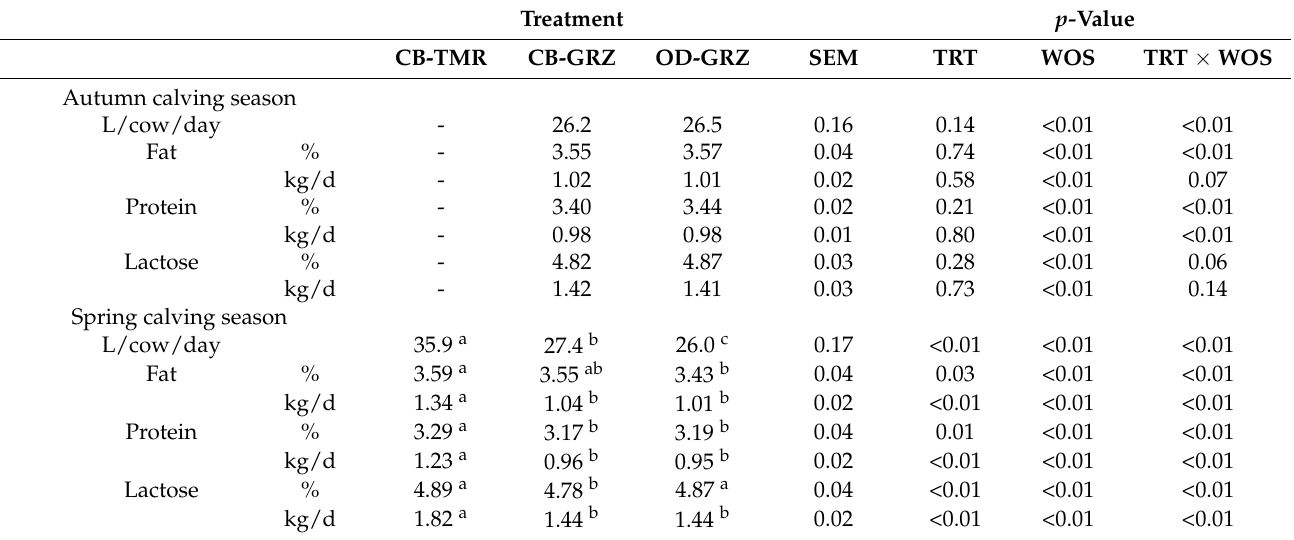
Table 4. Milk production and composition (means ± SEM) per cow in autumn and spring calving sea- sons in confined (CB-TMR) and mixed systems with low (CB-GRZ) or high (OD-GRZ) environmental exposure during complete